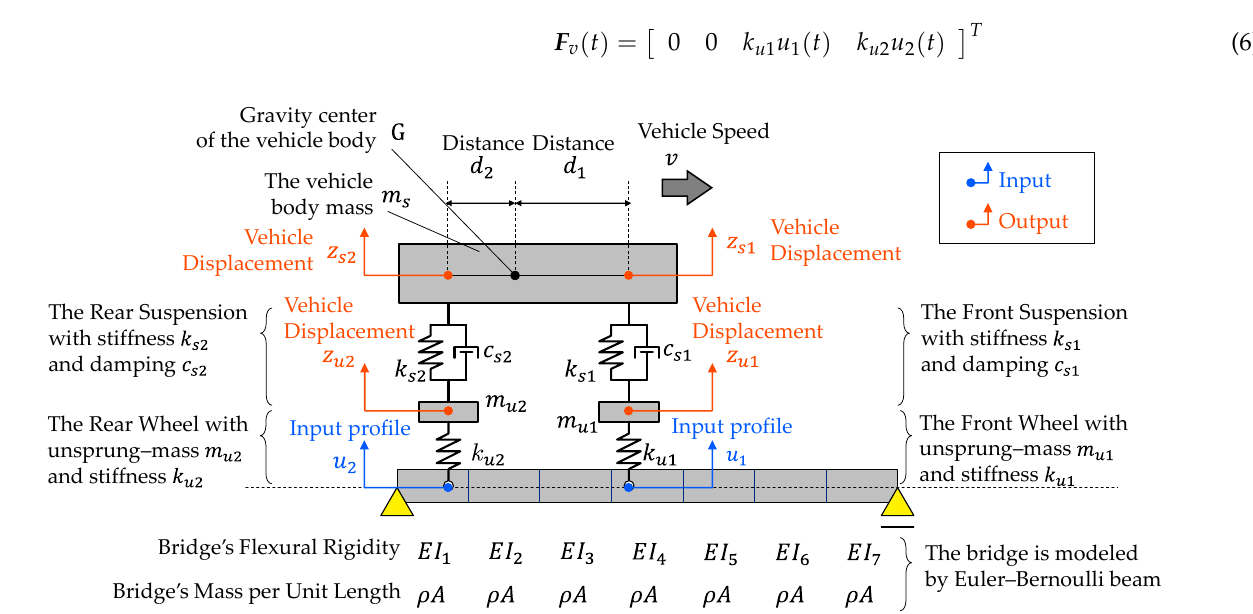
Figure 2. The adopted model and mechanical parameters of the VBI (vehicle–bridge interaction) system: The vehicle is assumed as an RBSM (rigid-body-spring model), while the bridge model is based on the Euler–Bernoulli theorem.